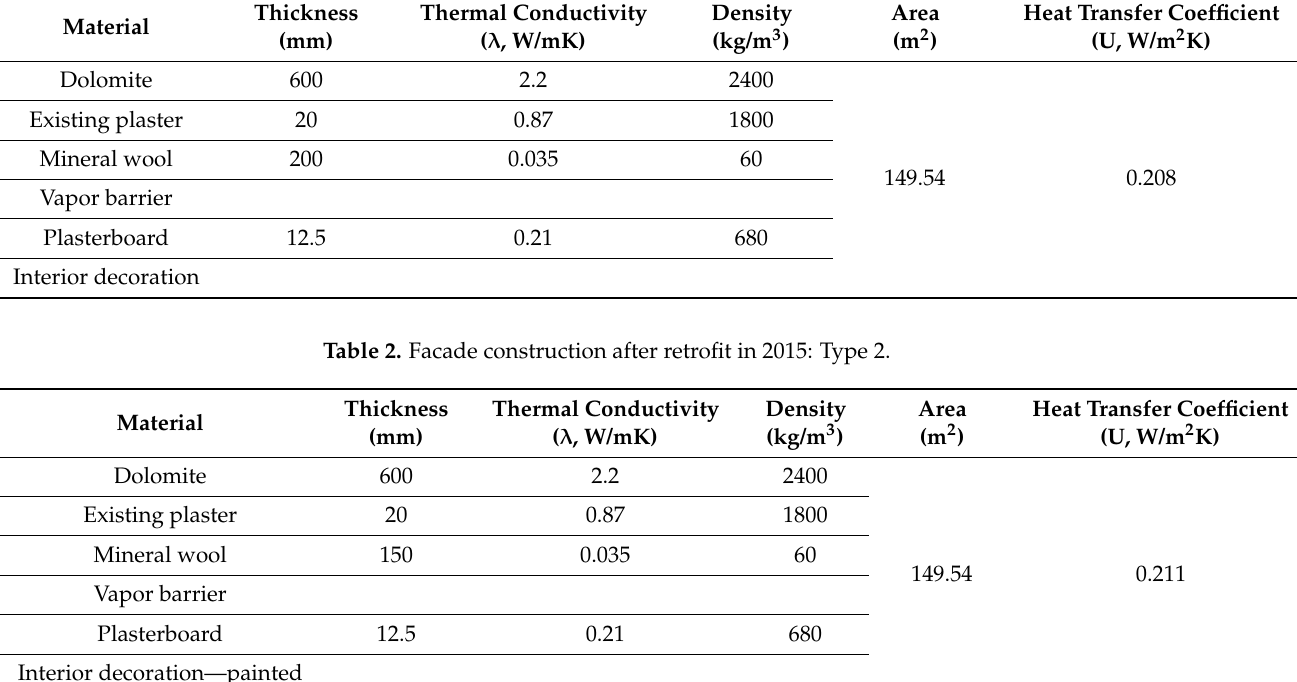
Figure 5. Location of four wall construction types in zones A2 after renovation in 2015, on the left 1st floor, on the right 2nd floor: type 1(purple), type 2 (orange), type 3 (green), and type 4 (blue). Tables 1–4 contain detailed information about the different types of external walls. Table 1. Facade construction after retrofit in 2015: Type 1.